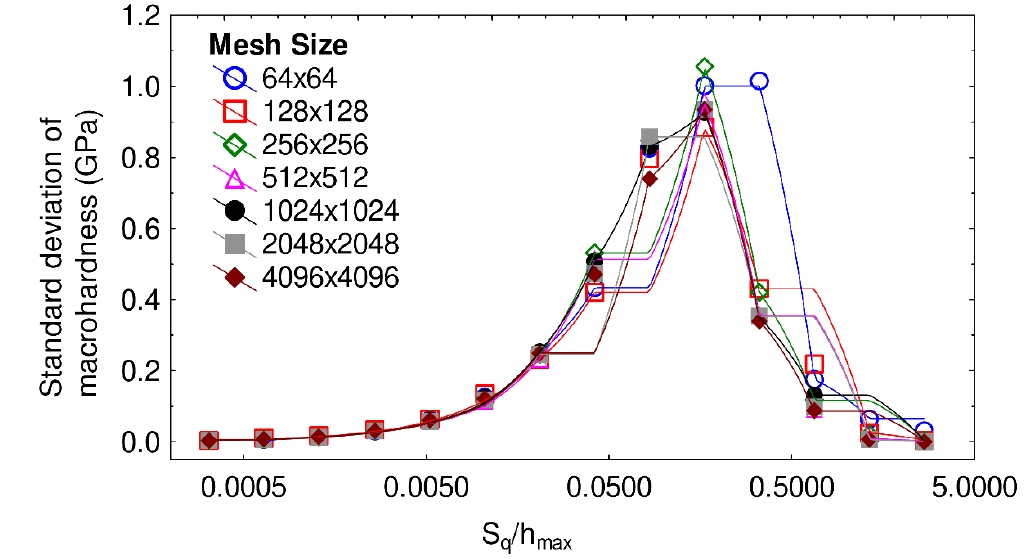
Figure 5. Standard error of macrohardness as a function of the ratio S q /h max , for different mesh sizes. The wavelength and fractal dimension of the tested surfaces are, respectively, set to 32 µm and 2.5.